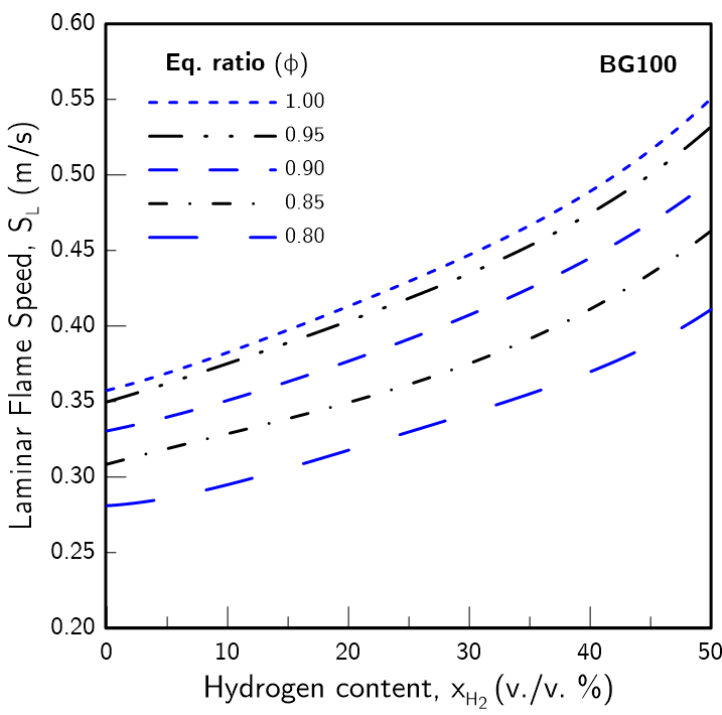
Figure 1. The laminar flame speed of biogas (BG100)/air flames enriched with H corresponds to the model results for a determined equivalence ratio ( φ ). Conditions were set at p = 1atm and T u =